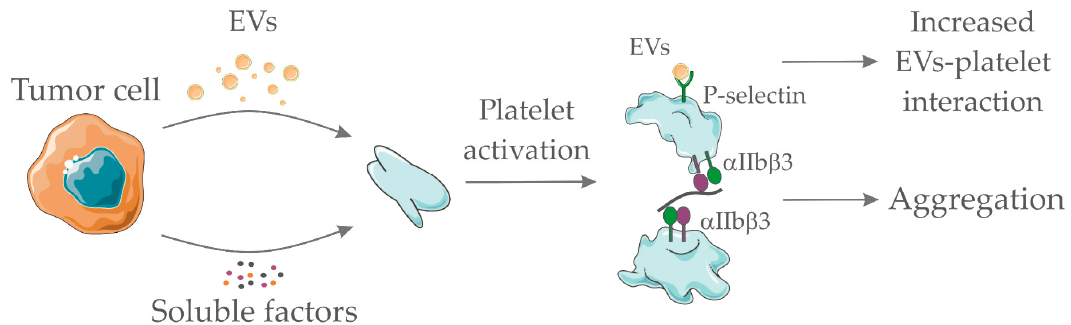
Figure 1. Pro-hemostatic interactions between tumor cell-derived soluble factors / extracellular vesicles (EVs) and platelets. Tumor-derived EVs and / or tumor-derived soluble factors (such as adenosine diphosphate, thromboxane A2, and others) interact with platelets promoting their activation. Platelet activation accounts for integrin α IIb β 3 exposure and further interaction with fibrinogen, thus enabling platelet aggregation. In addition, platelet activation promotes P-selectin exposure which serves as a ligand for P-selectin glycoprotein ligand 1 (PSGL1)-containing EVs. EVs interaction with platelets favor their accumulation at the site of thrombotic injury. Together, both processes favor thrombus formation. Servier Medical Art, https://smart.servier.com/, was used to